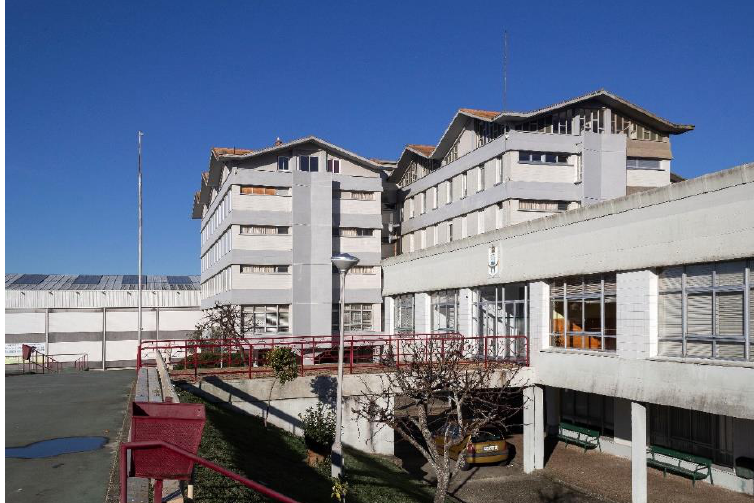
Figure 1. Paulist School in Marín (Marín, Pontevedra, 1970), by Elena Arregui Cruz-López and Arturo Zas Aznar. Photo credit: María Novas.